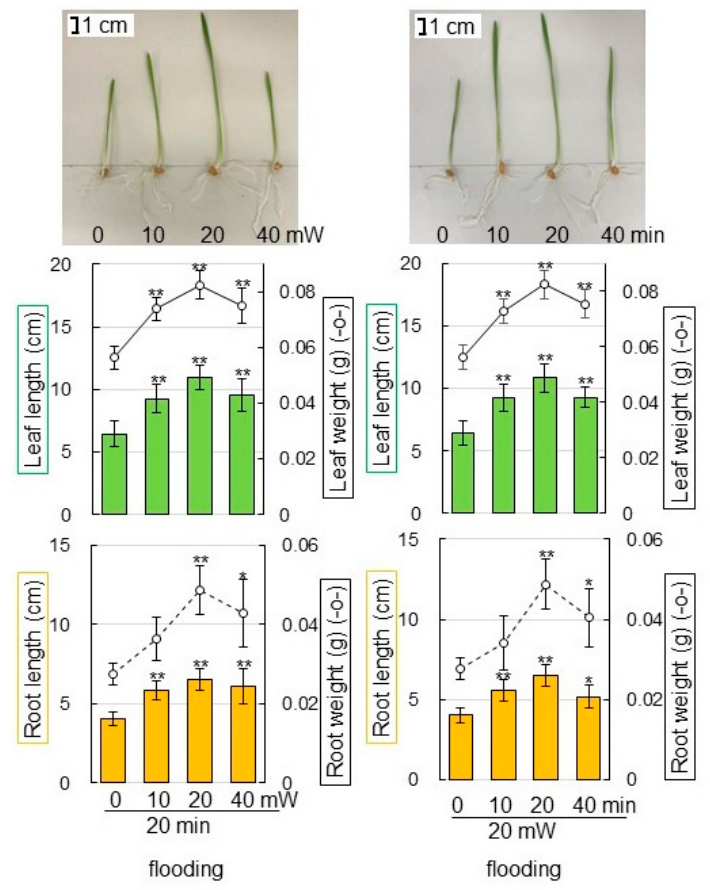
Figure 1. Morphological effect of millimeter-wave irradiation with the various power and time on wheat under flooding stress. Wheat seeds were irradiated with 0, 10, 20, and 40 mW of millimeter waves for 0, 10, 20, and 40 min and sowed (Figures S1 and S2). For non-flooded group, samples were collected at 6 days after sowing (Figure S3). For flooded group, wheat seedlings were treated with 3-day flooding after 3-day germination and samples were collected. Leaf length (green column), leaf-fresh weight (black solid line graph), main-root length (orange column), and total-root fresh weight (black dotted line graph) were measured as morphological parameters. Bar indicates 1 cm. The data are given as the mean ± SD from three independent biological replicates. Asterisks indicate significant changes of irradiated groups compared with unirradiated group according to Student’s t -test (** p < 0.01; * p < 0.05).